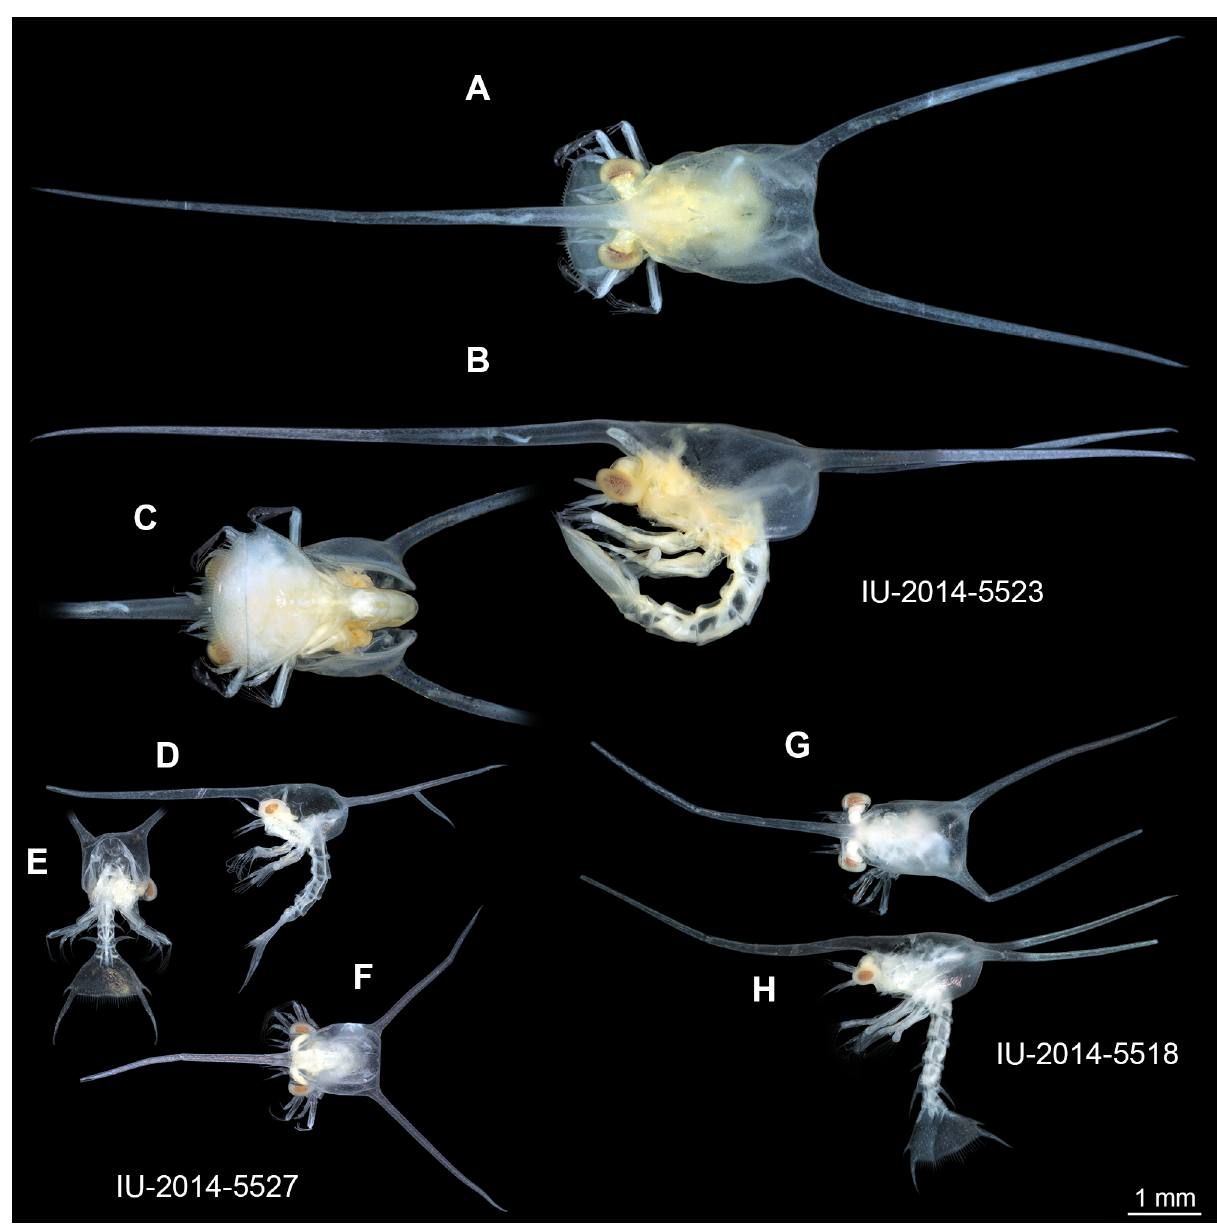
Figure 2. Larvae of the group Albuneidae, museum specimens under cross-polarized light. A–C : Specimen MNHN-IU-2014-5523. A . Dorsal view. B . Lateral view. C . Ventral view. D–F : Specimen MNHN-IU-2014-5527. D . Lateral view. E . Posterior view. F . Dorsal view. G, H : Specimen MNHN-IU-2014-5518. G . Dorsal view. H . Lateral